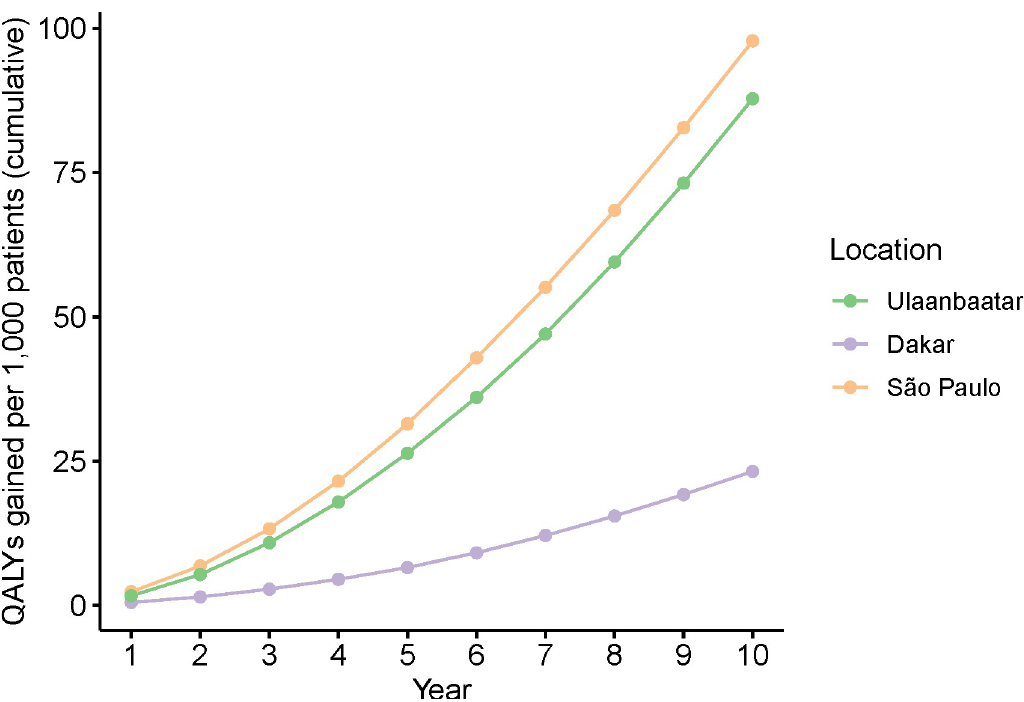
Fig 3. Predicted cumulative number of QALYs gained per 1,000 treated patients under CARDIO compared to the ‘No CARDIO’ scenario over a 10-year projection phase in Ulaanbaatar, Dakar, and S ã o Paulo.